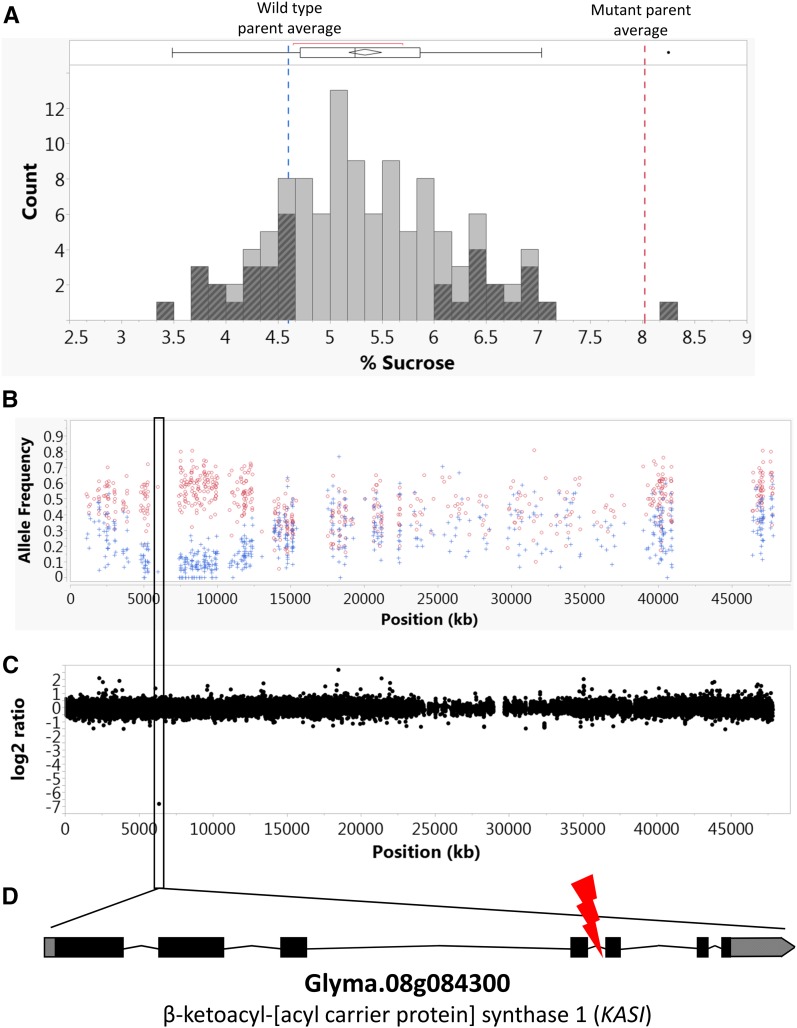
A flow chart of trait mapping. Bulked Segregant Analysis (BSA) was performed on an F2 outcross population to identify a structural variant in a β-ketoacyl-[acyl carrier protein] synthase 1 (KASI) ortholog associated with a high-sucrose/low-oil phenotype. (A) A histogram of sucrose content, as measured by the colorimetric assay, for the 113 individuals in the F2 population (“Noir 1” × FN0176450). Shaded histogram bars indicate those individuals that were selected for BSA and the vertical red and blue dashed lines indicate the parental phenotypes. Two bulks of DNA were formed (high-sucrose individuals and low-sucrose individuals) for whole-genome sequencing. (B) The allelic ratio for each single nucleotide polymorphism (SNP) along chromosome 8 in the high-sucrose (red data points) and low-sucrose bulks (blue data points). (C) The array comparative genomic hybridization (aCGH) graph displays the log2 ratio of the mutant genotype vs. the “M92-220” reference, where each dot represents a single aCGH probe. If the log2 ratio is <0, that indicates that the probe had a stronger signal intensity in wild type than in mutant, while a log2 ratio >0 would indicate a stronger signal intensity in mutant than wild type. A black box was drawn around a single probe with a low log2 ratio (log2 ratio = −6.5) highlighting that this probe was likely present in the wild-type line and absent in the high-sucrose/low-oil mutant line. (D) A structural variant between the fourth and fifth exon of Glyma.08g084300, indicated by the red lightning bolt.